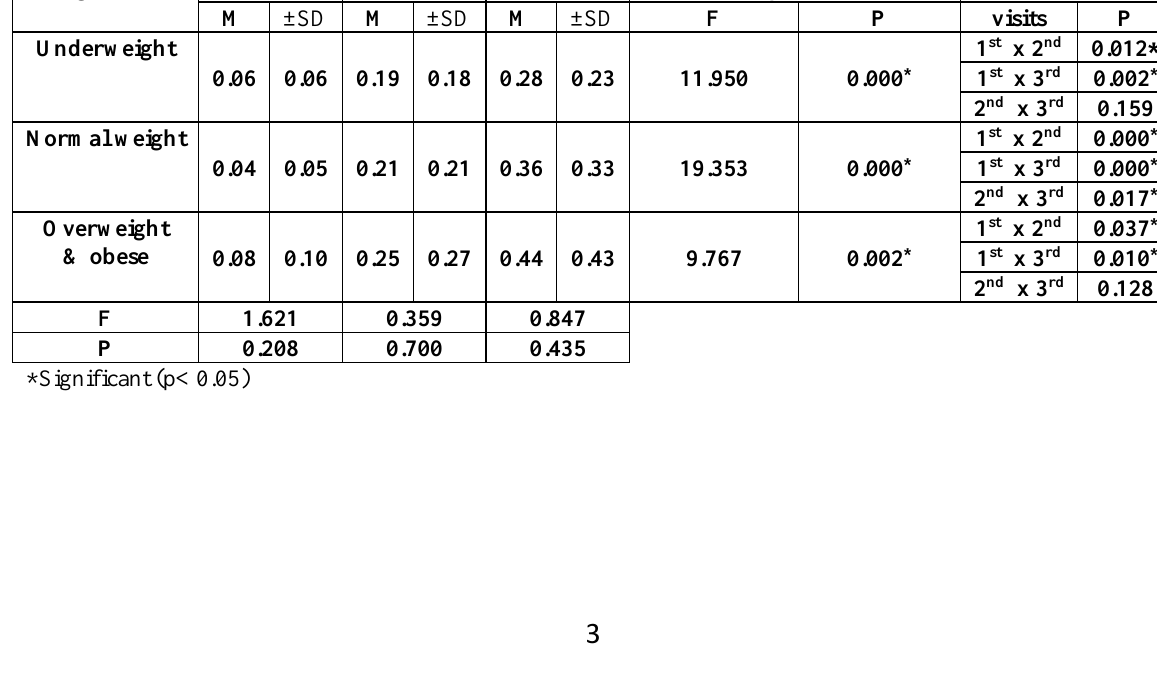
Table 3: Descriptive and statistical test of gingival index changes through visits and by weight status. Weight status